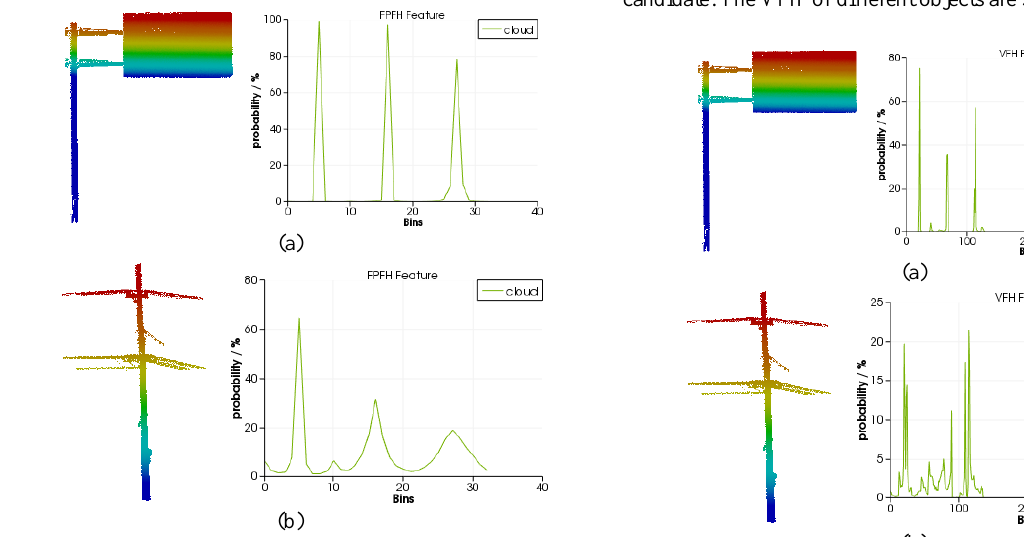
Figure 4. The FPFHs of different kinds of objects: (a) the FPFH of traffic sign, (b) the FPFH of utility pole.